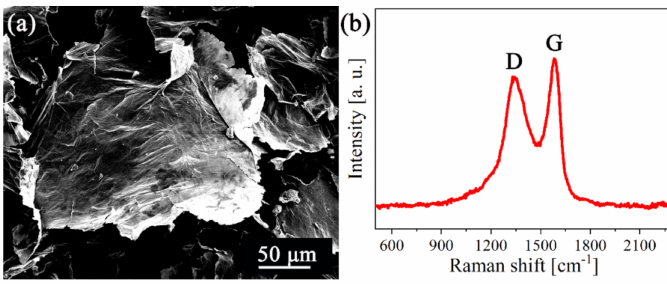
Figure 1. ( a ) Morphology and ( b ) Raman spectrum of GOs.